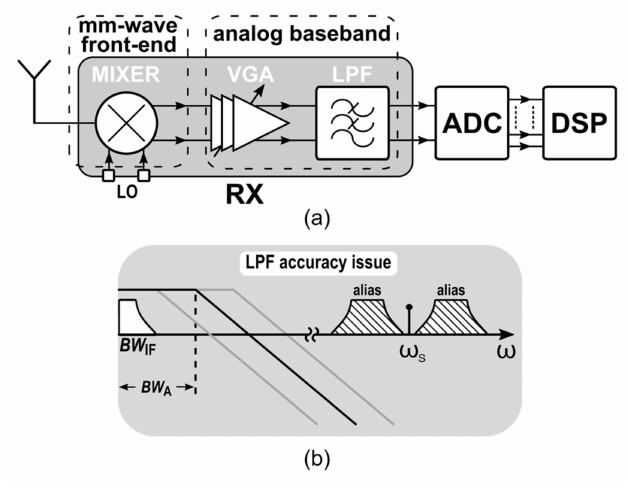
Figure 1. ( a ) Simplified block-diagram of a FMCW receiver. ( b ) LPF actual bandwidth over differ- ent